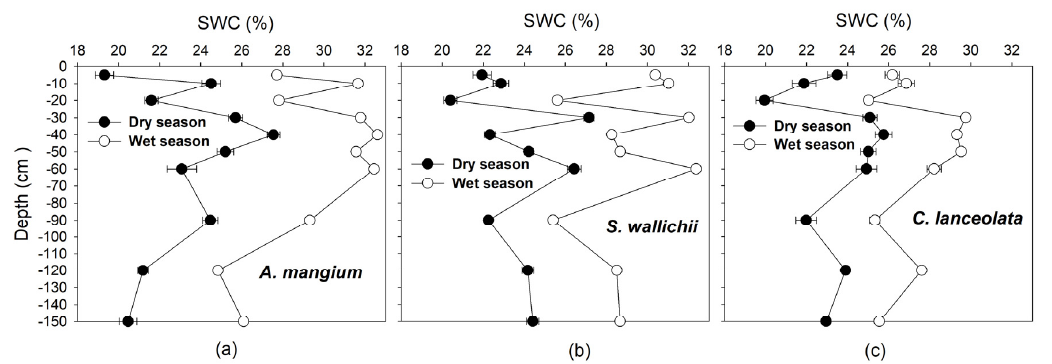
Figure 2. Soil water content (SWC± standard error) at 10 different depths in the dry and wet seasons at three sites. (a) A. mangium site; (b) S. wallichii site; (c) C. lanceolata site.